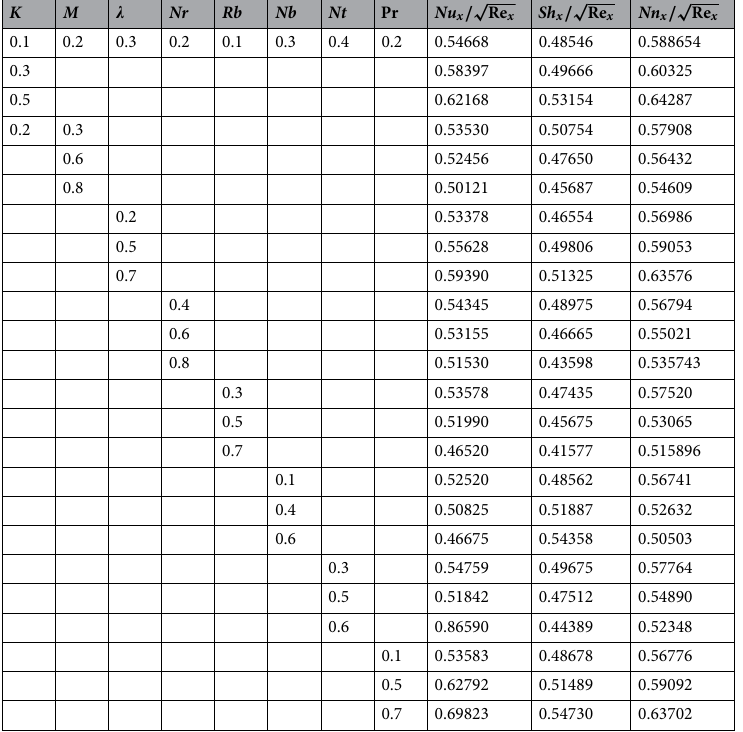
θ ξ ( 0, τ) , φ ξ ( 0, τ) and − −